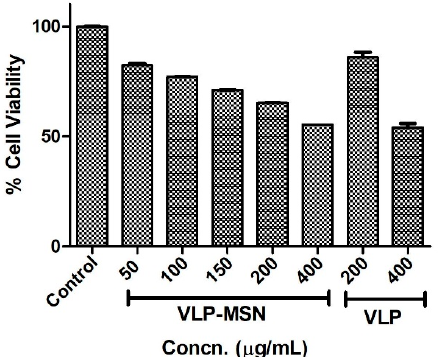
Figure 9. Cell viability of HEP G2 cell line after exposure to neat VLP and VLP-MSNs for 24 h. Error bars indicate the standard deviation ( n = 3).